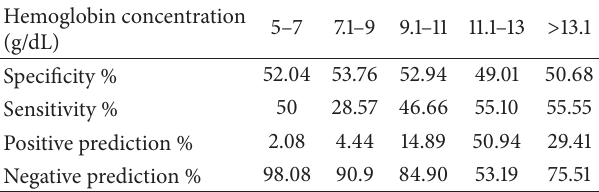
Table 1: Reliability of WHO color scale with the reference method (cyanmethemoglobin method).